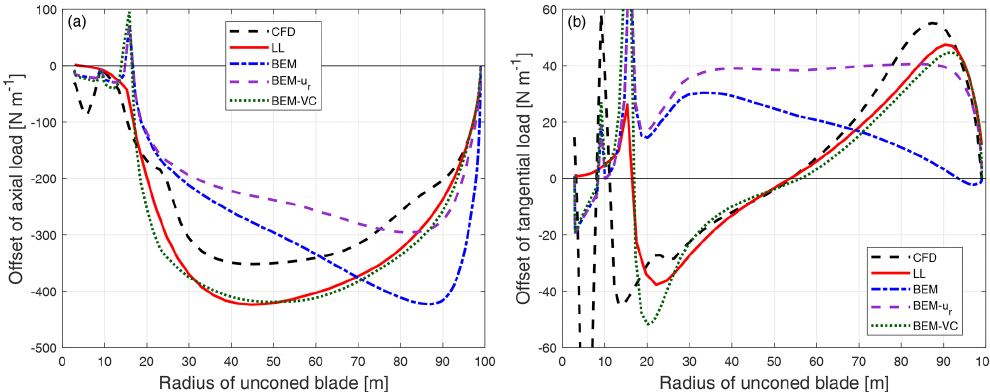
Figure 13. Comparison of the difference of the axial load (a) and tangential load (b) of the baseline blade with 15 ◦ of cone upwind compared to the baseline blade without cone calculated from CFD, the lifting-line method (LL), the BEM method, BEM with radial induction (BEM- u r ) and the proposed BEM-VC method.